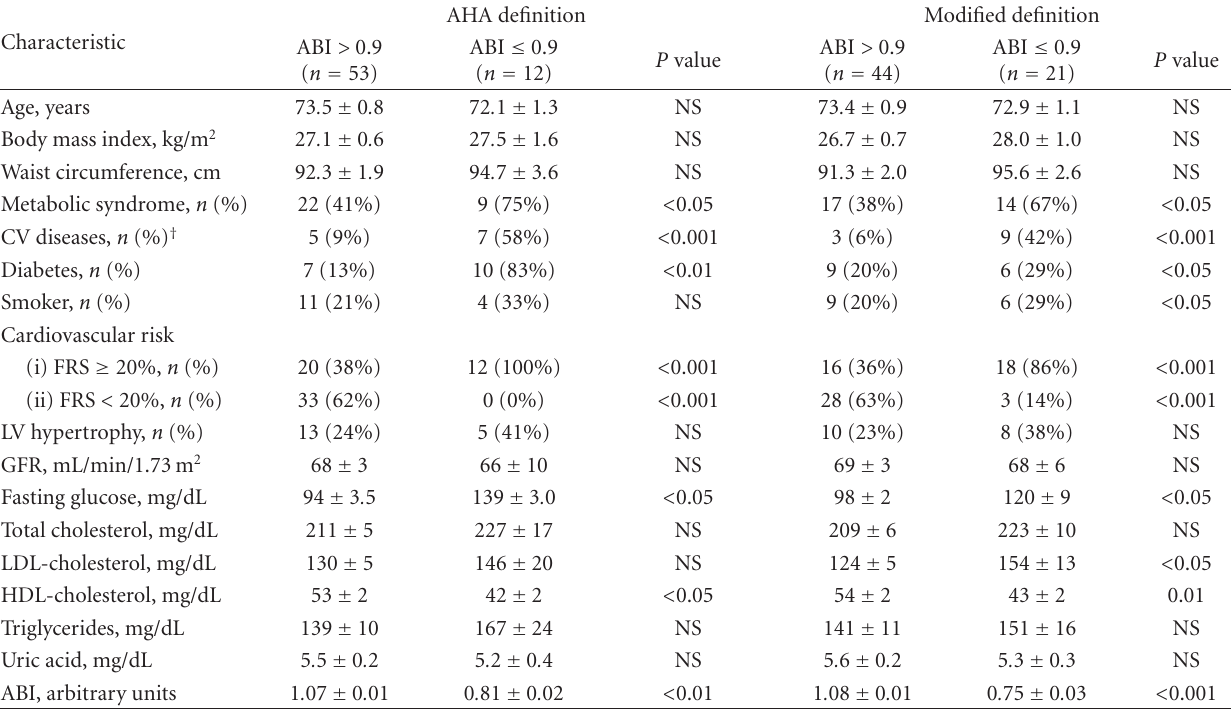
Table 2: Clinical and laboratorial characteristics of the groups with normal ( > 0.9) and low ( ≤ 0.9) ankle-brachial index (ABI) obtained by AHA/TASC II standardization and by modified